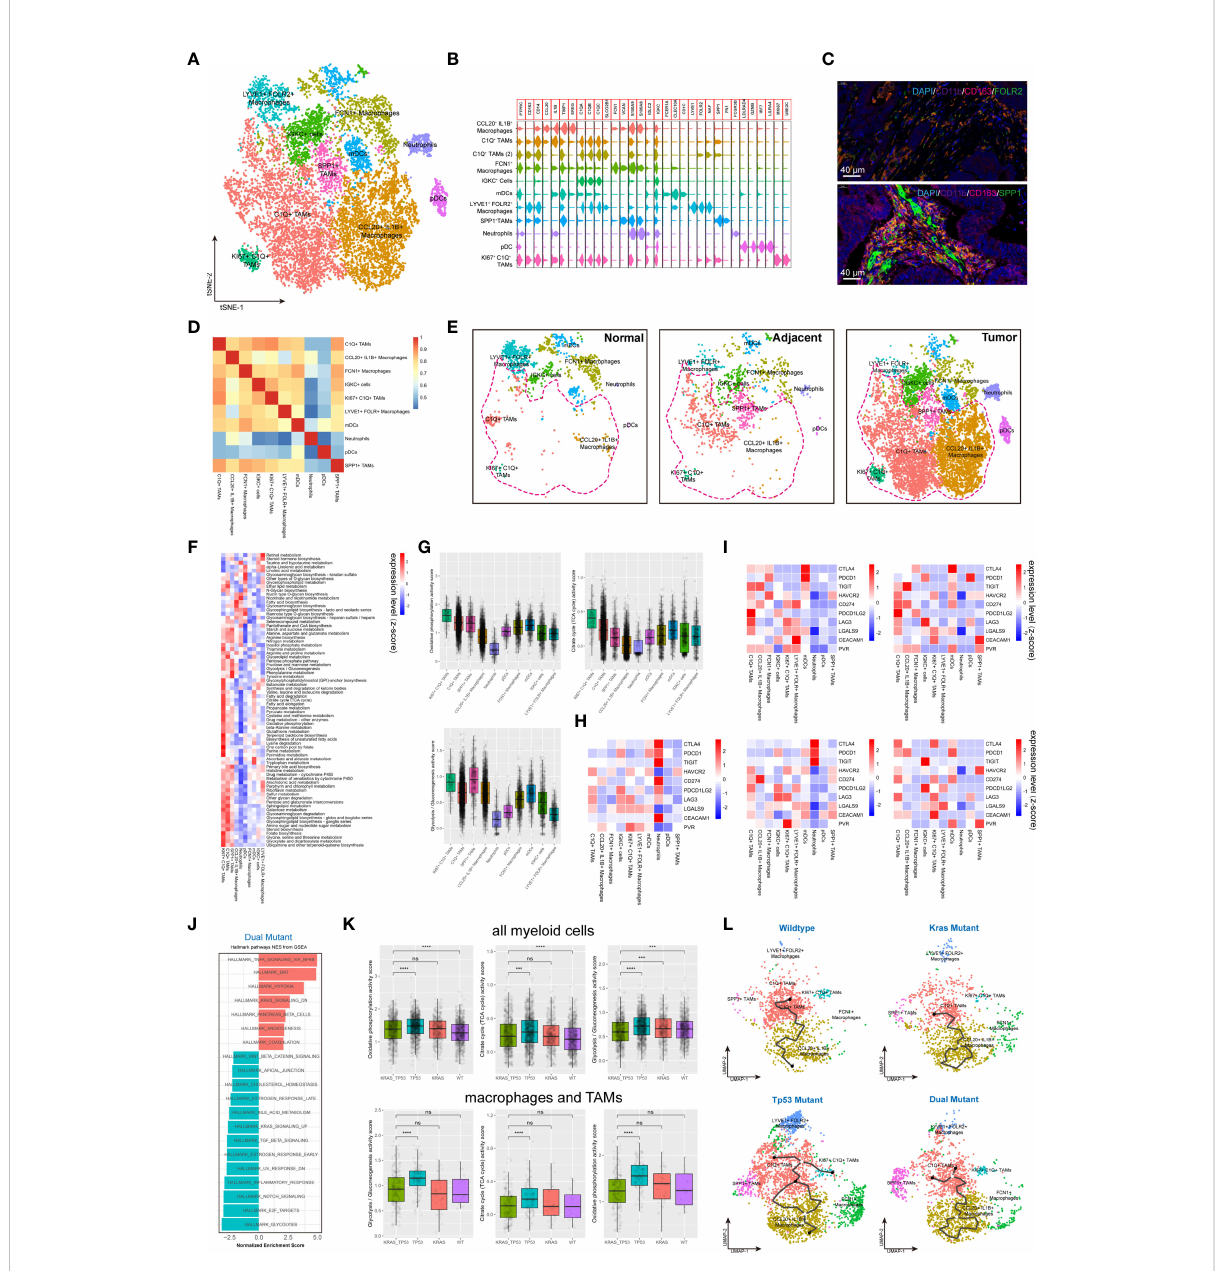
FIGURE 5 Tumor-in fi ltrating myeloid cells exhibit molecular plasticity and metabolic heterogeneity according to tumor sideness and KRAS/TP53 mutation status. (A) UMAP dimension reduction of 14,680 myeloid cells (containing myeloid cells derived from normal mucosa, tumor adjacent and tumor tissue), and visualization of the features based on UMAP clusters. (B) The violin plot presented the expression levels of canonical myeloid cell markers across cell types. (C) Representative images of immuno fl uorescent-stained DAPI, CD11b, CD163, FOLR2 (upper) and SPP1 (lower) in human colorectal cancer. (D) The heatmap displayed spearman correlation between various myeloid cell subpopulations based on the top 500 genes with the highest standard deviation. (E) Visualization of the distribution of myeloid cell types across normal mucosa (left), tumor adjacent (middle) and tumor tissue (right). (F) The heatmap of signi fi cantly enriched metabolic pathways (p < 0.001) across tumor-in fi ltrating myeloid cell types. The bar represented the row-scaled pathway enrichment level. (G) The boxplots presented the levels of Oxidative phosphorylation (upper left), Citrate cycle (TCA cycle) (upper right) and Glycolysis/Gluconeogenesis (lower) activity score across distinct tumor-in fi ltrating myeloid cell types. (H, I) The average expression levels of immune checkpoint molecules among different subtypes of (H) all tumor-in fi ltrating myeloid cells, and (I) the expression according to KRAS/TP53 mutation status. (J) The GSEA analysis of DEGs of myeloid cells derived from KRAS/TP53 dual mutant colorectal cancers. (K) The boxplots showed the levels of Oxidative phosphorylation, Citrate cycle (TCA cycle) and Glycolysis/ Gluconeogenesis activity score of tumor-in fi ltrating myeloid cells according to KRAS/TP53 mutation status in all myeloid cells (upper) and tumor-associated macrophages (lower). (L) The trajectory plot (monocle3) showed the dynamics of all tumor-in fi ltrating macrophages subclusters and their pseudotime-associated cell state based on KRAS/TP53 mutation status. ns, not signi fi cant; ***p < 0.001; ****p <